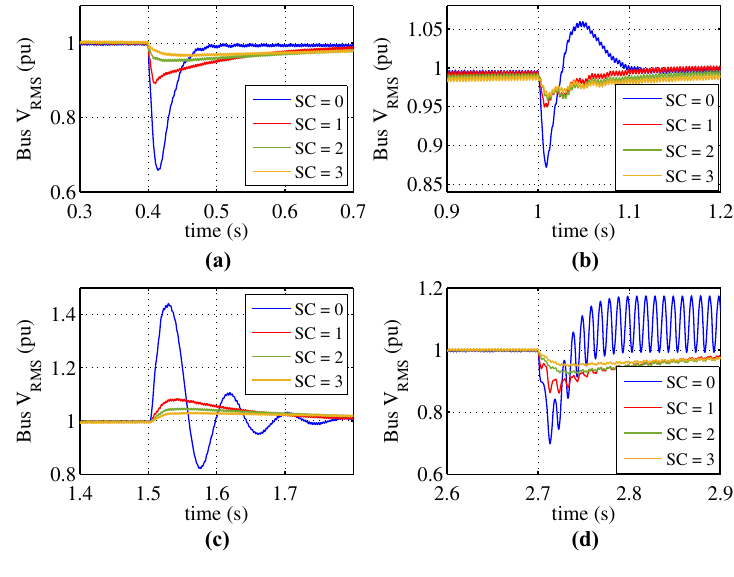
Figure 6. Bus RMS voltage (p.u.) compare with different number of SCs under (a) resistive load connected, (b) inductive load connected, (c) resistive load disconnected, (d) single-phase load